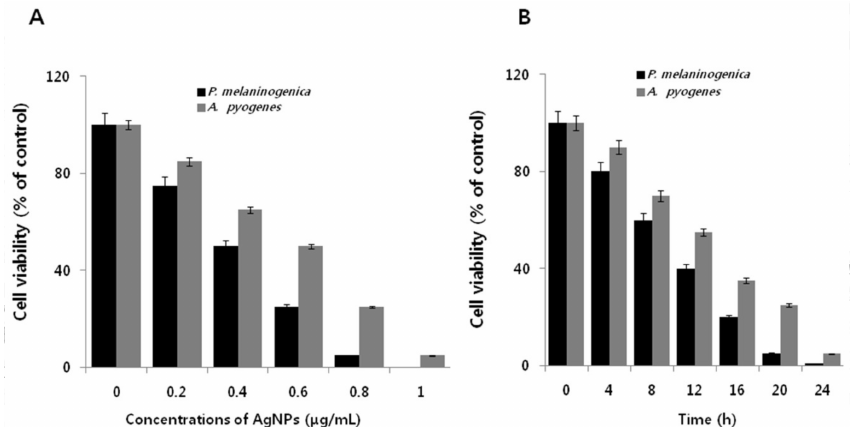
Figure 3. Antibacterial activity of AgNPs on P. melaninogenica and A. pyogenes. ( A ) P. melaninogenica and A. pyogenes were incubated with various concentrations of AgNPs. Bacterial cell survival was determined at 24 h based on a CFU count assay. ( B ) P. melaninogenica and A. pyogenes cells were incubated with 0.8 and 1.0 µ g/mL of AgNPs, respectively, for 24